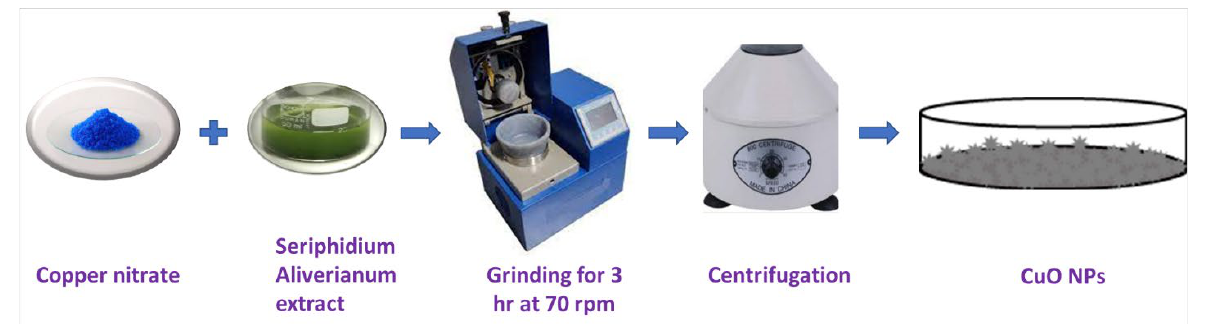
Figure 11. Mechanochemical synthesis of biogenic CuO NPs.